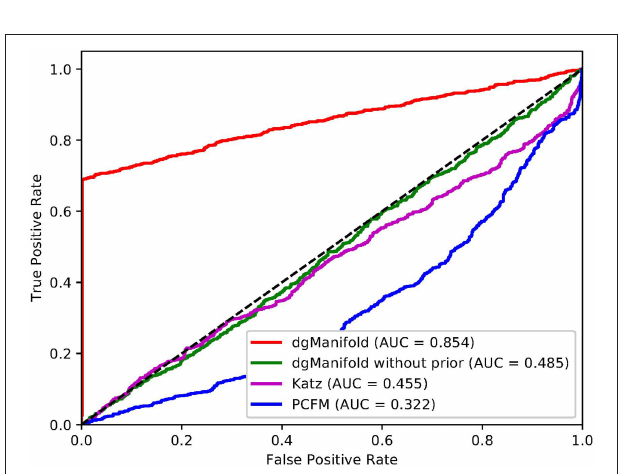
FIGURE 2 | ROC curves of the three competing algorithms on single-gene diseases.